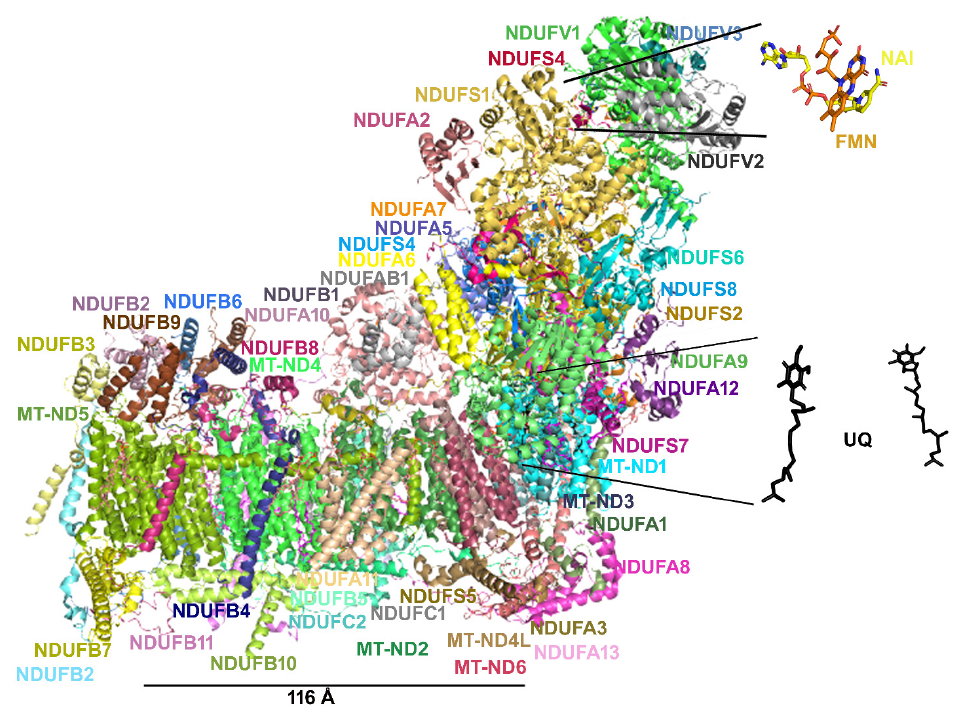
Figure 4. The sus complex I structure (7v2r.pdb, [157]) is reported in colored cartoon representation as a representative complex I structure from mammalian species. The same color scheme is used for the labels indicating each reported subunit. The subunits NUDFA7, NDUFC1 and NDUFB1 are not viewable in this side view. FMN and NAD+ are reported in orange and yellow sticks, as shown in the zoomed view, at the level of subunit NDUFV1. UQ is reported in black sticks as shown in the zoomed view, at the level of MT-ND1, NDUFS2, NDUFS7 and NDUFA9. The distance between the center of mass of ND5 and the center of mass of the closest ubiquinone molecule is represented by the black solid line, here used as a reference distance.